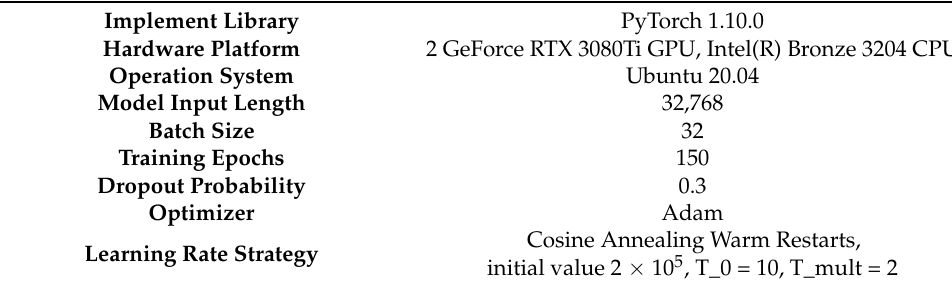
Table 1. SCN training parameters.